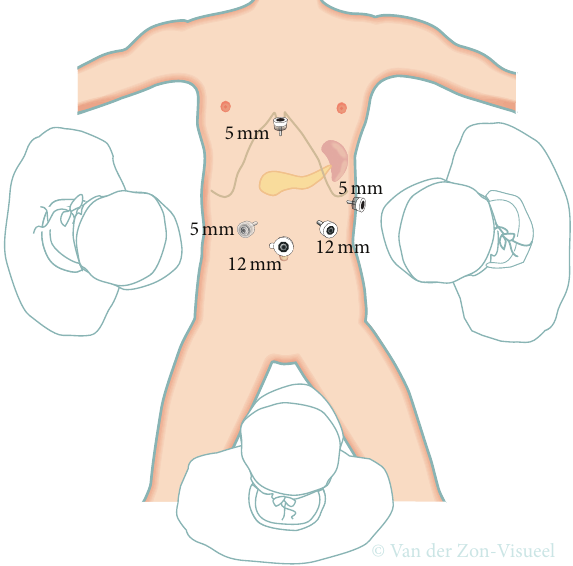
Figure 1: Trocar placement for laparoscopic distal pancreatectomy. Transparent 5 mm trocar is the additional trocar recommended during laparoscopic distal pancreatectomy for cancer as it will facilitate lymphadenectomy at the hepatic artery and celiac